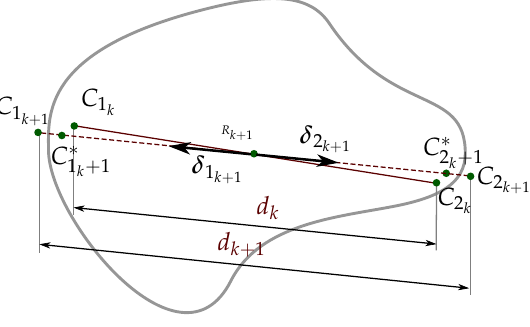
using C ∗ , adjusting the distance d k to d k + 1 when the i k + 1 k + 1